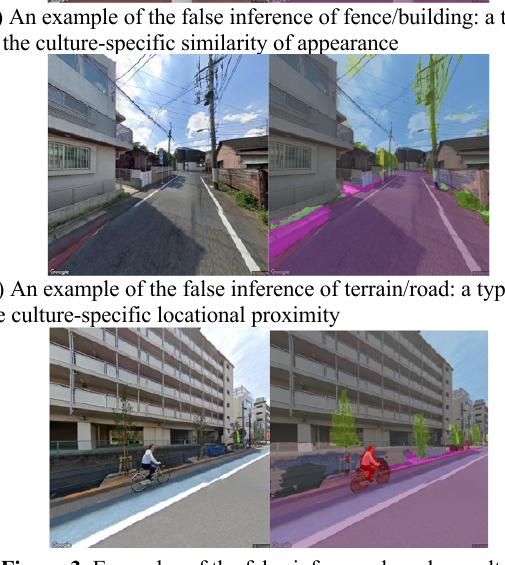
Figure 3 . Examples of the false inference based on culture- specific fixed configuration of streets (image/inference